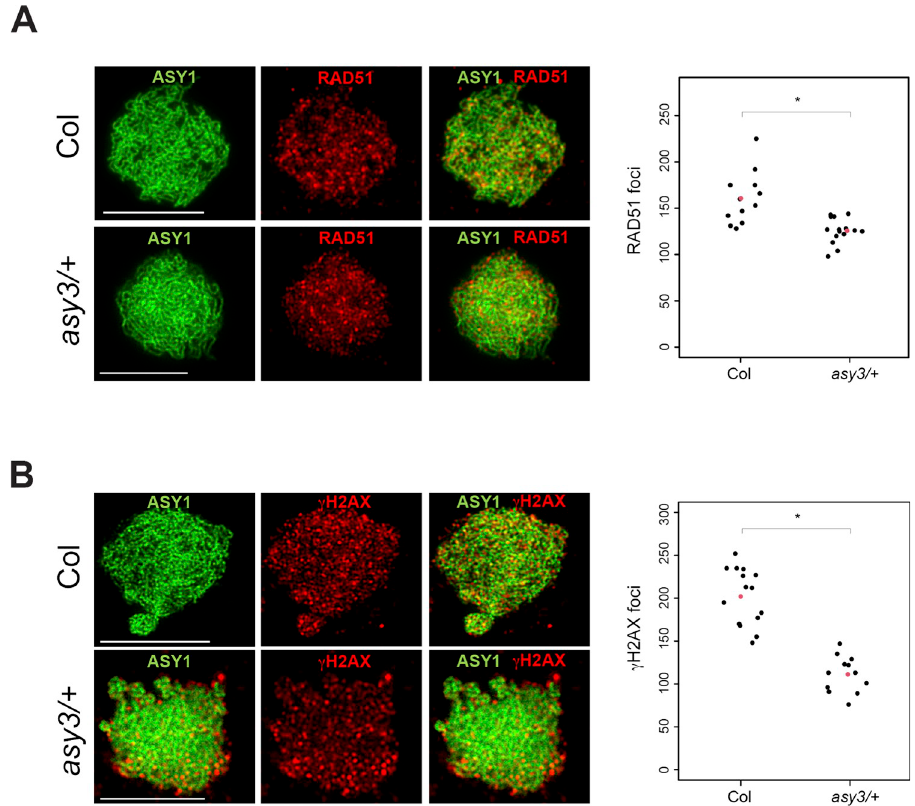
Fig 5. ASY3 gene copy number influences DSB formation. ( A ) Co-staining of ASY1 (green) and RAD51 (red) in wild type (Col) and asy3/+ heterozygotes. Plot showing counts of RAD51 foci in wild type (Col) and asy3/+ . Black dots represent individual measurements, and red dots represent mean values. A Mann-Whitney-Wilcoxon test was used to compare counts of RAD51 foci between wild type (Col) and asy3/+ . “ � ” indicates a statistically significant difference. ( B ) Co-staining of ASY1 (green) and γ H2AX (red) in wild type (Col) and asy3/+ heterozygotes. Plot showing counts of γ H2AX foci in wild type (Col) and asy3/+ . Black dots represent individual measurements, and red dots represent mean values. A Mann-Whitney-Wilcoxon test was used to compare counts of γ H2AX foci between wild type (Col) and asy3/ + . “ � ” indicates a statistically significant